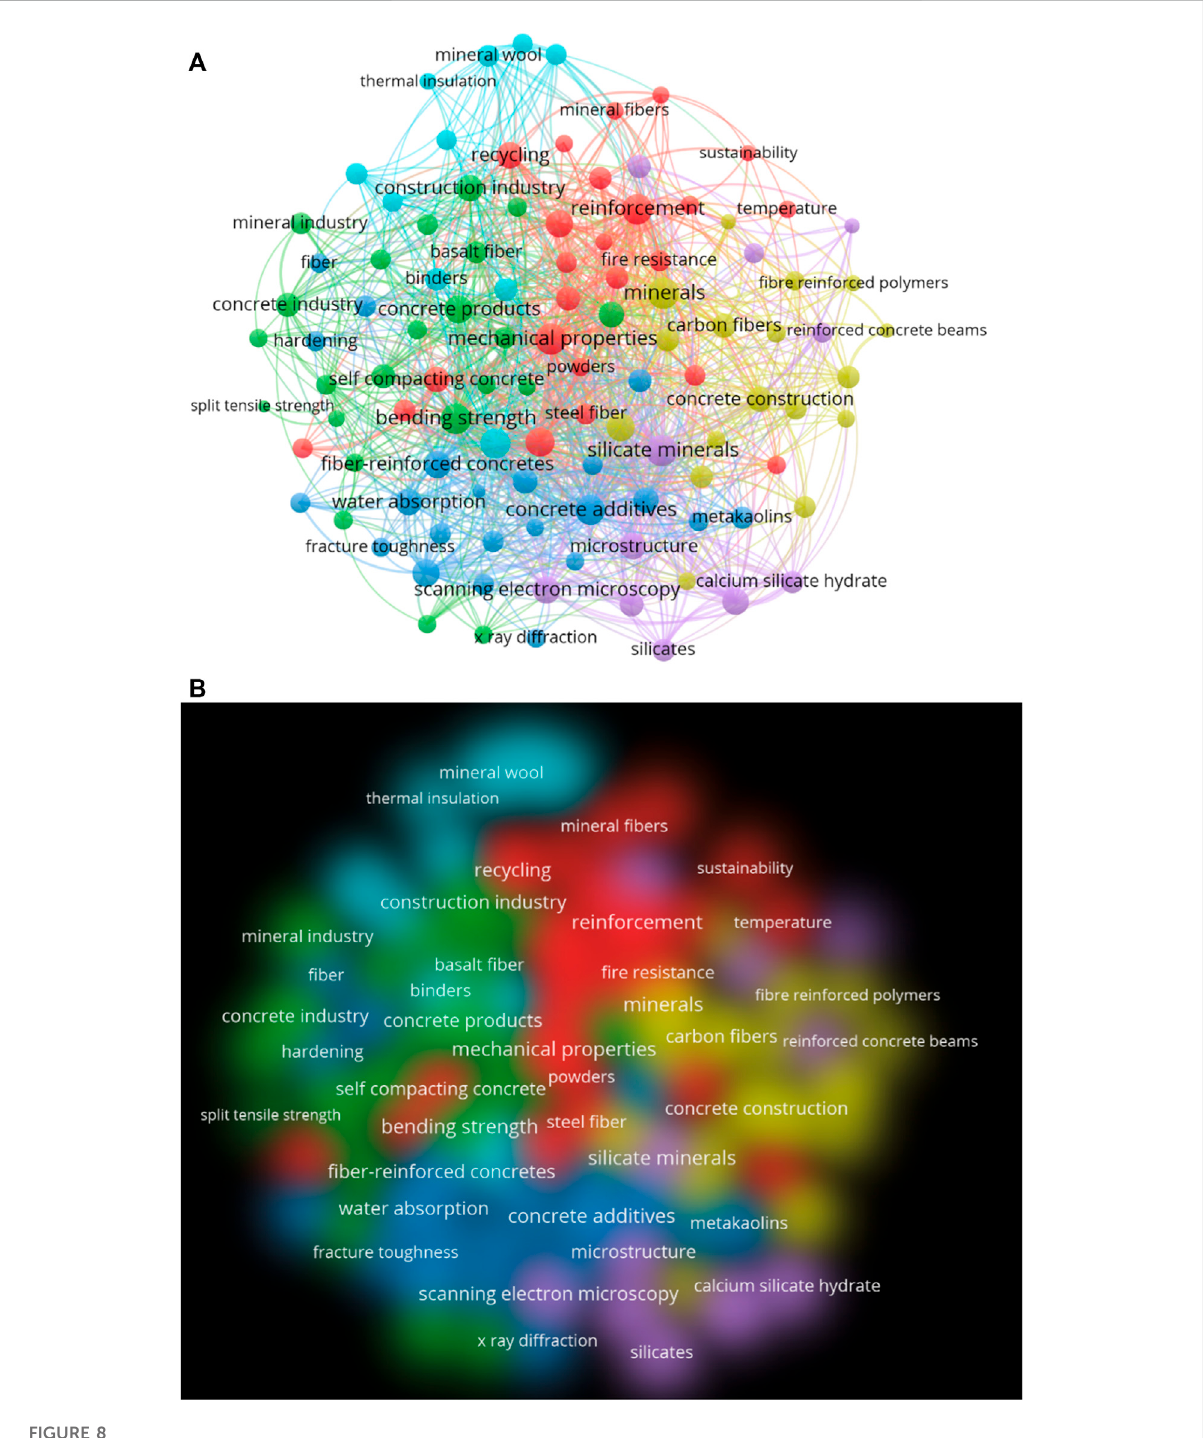
Mapping of keywords having at least 15 publications. (A) Network visualization; (B)